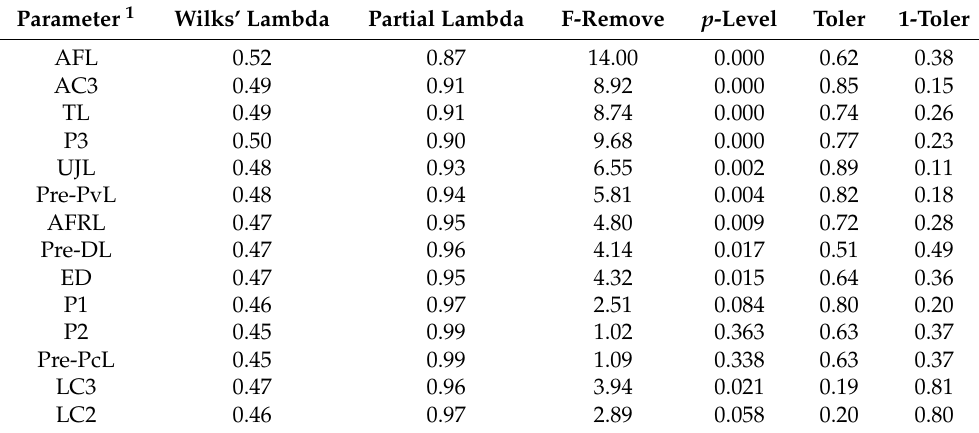
Table 4. Discriminant functions for truss measurements in three populations of Brycon dentex .